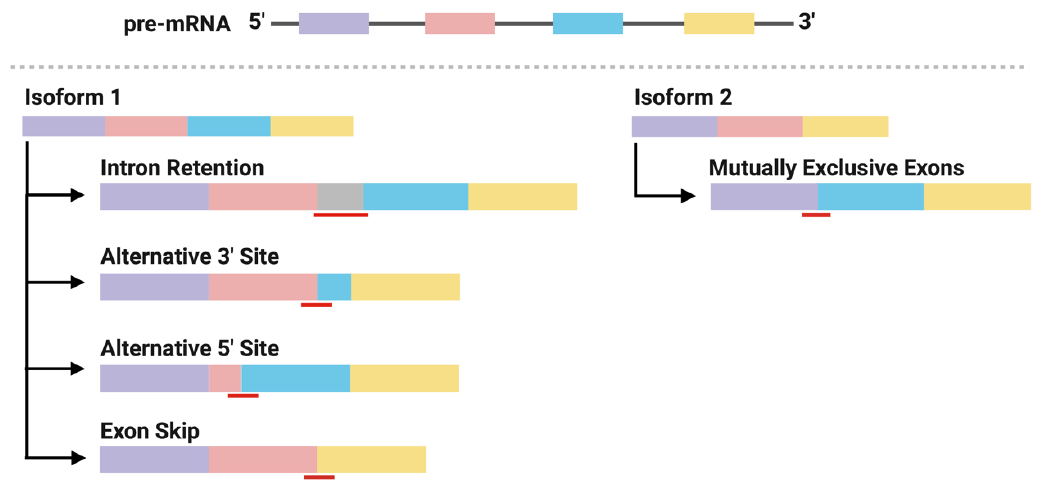
Figure 2. Mutations in cis- and trans-acting splicing elements may form neojunctions predominately expressed in cancer cells through alternative splicing patterns. Schematic view of constitutive splicing of 2 mRNA isoforms from a shared pre-mRNA transcript and their respective alternative splicing patterns forming neojunctions. Black lines represent introns, boxes represent exons and red lines represent neojunctions.